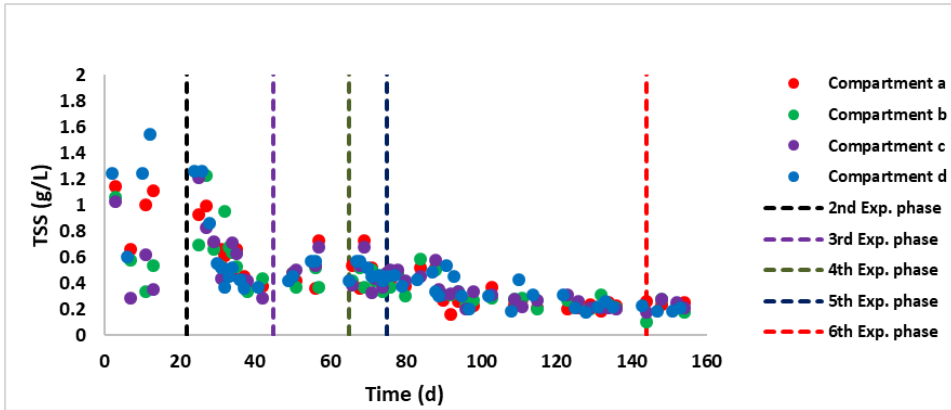
Figure 9 . Daily TSS concentration in reactor compartments. Figure 9. Daily TSS concentration in reactor compartments.